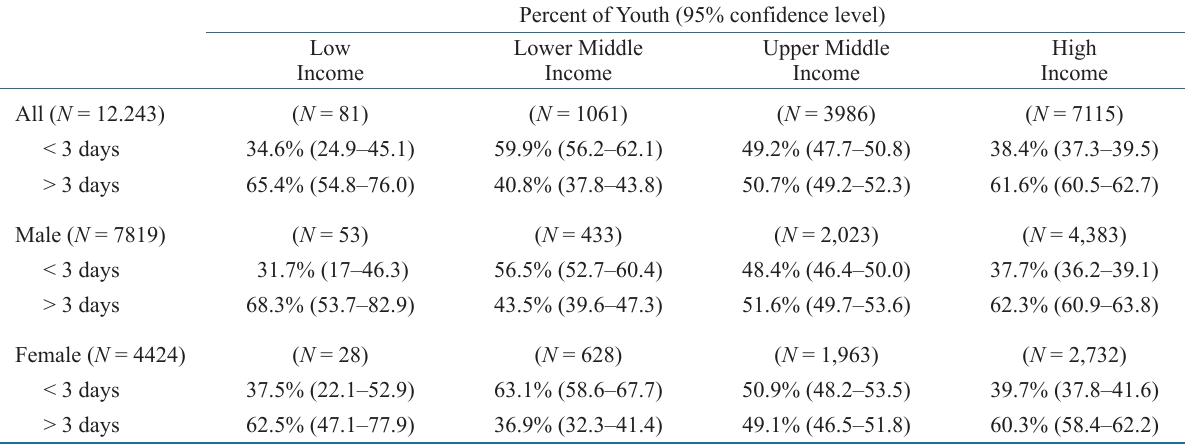
Physical Activity Frequency of Special Olympics Participants by economic status